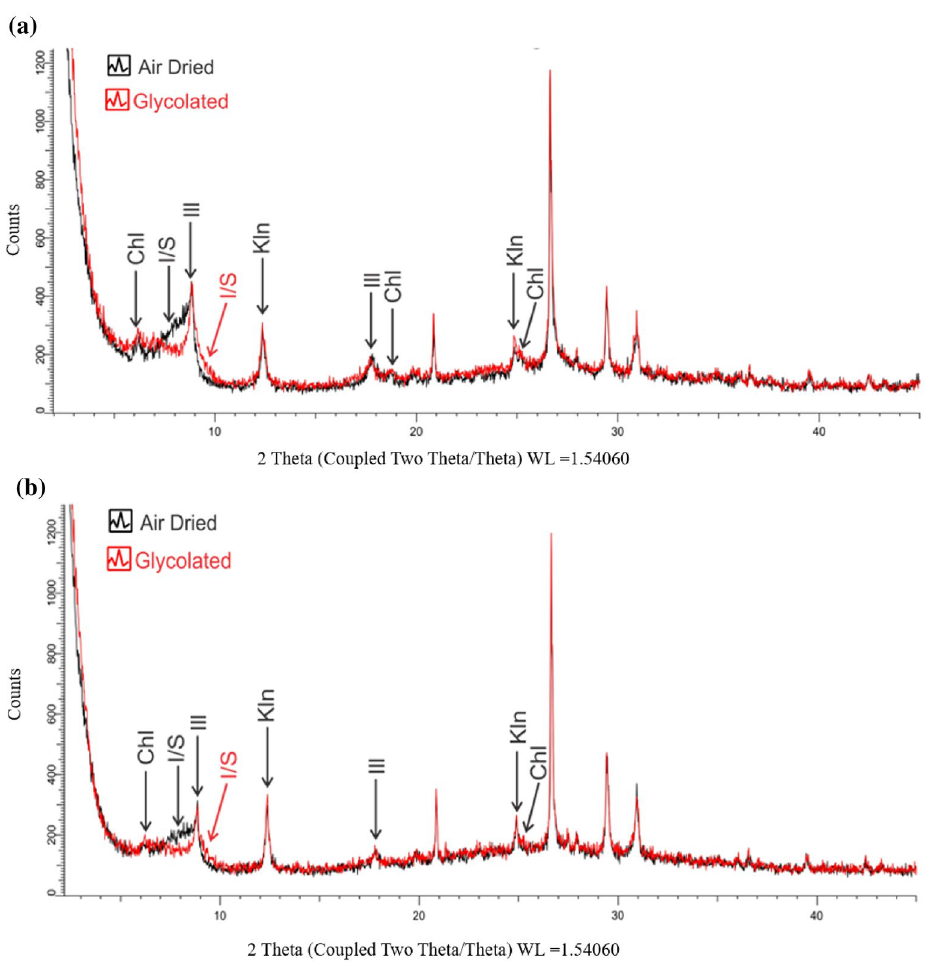
Figure 1. ( a ) XRD analysis of clay-sized fraction for both air dried and glycolated treatments in vertical pattern. ( b ) XRD analysis of clay-sized fraction for both air dried and glycolated treatments in horizontal pattern. (Glycolated: treated with ethylene glycol) [Illite (Ill), illite/smectite (I/S), Kaolinite (Kln), Chlorite (Chl)].